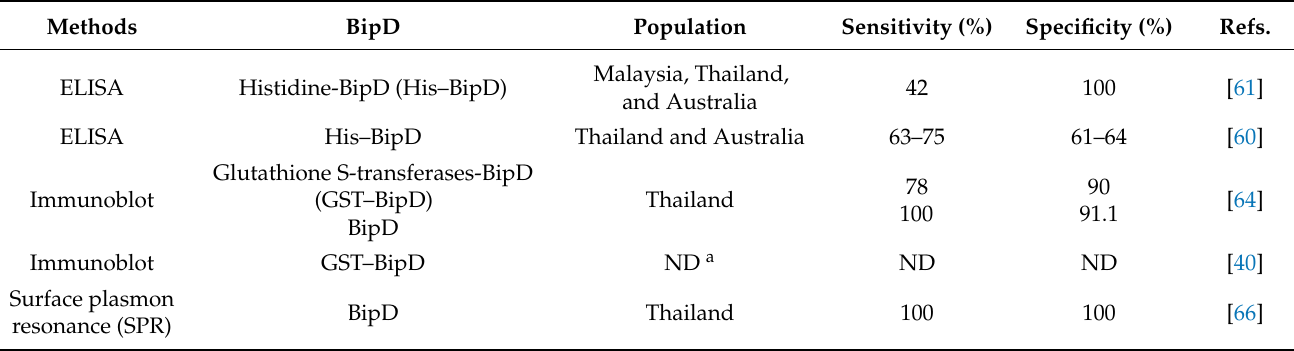
Table 3. Serodiagnostic assays using Burkholderia invasion protein (BipD) as the